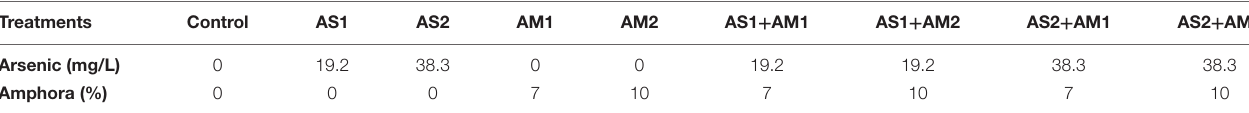
TABLE 2 | The fish groups exposed to arsenic (AS1, AS2) concentrations, amphora (AM1, AM2) percentages and their